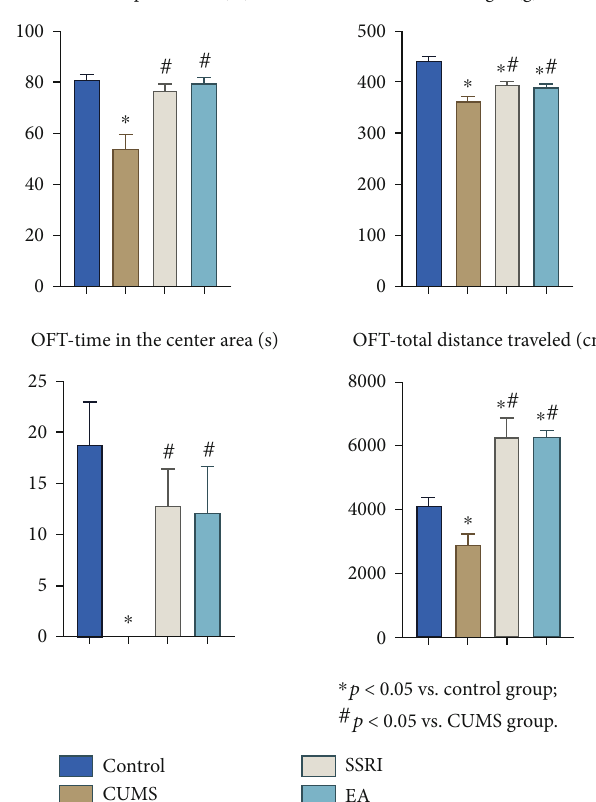
Figure 1: Comparison of SPT, weight, and OFT among 4 groups ( mean ± SEM ) (the OFT-time in the center area of the CUMS group was too much shorter than those of the other groups to show in the bar graph, but the speci fi c number is listed in Table 2) ( n = 15